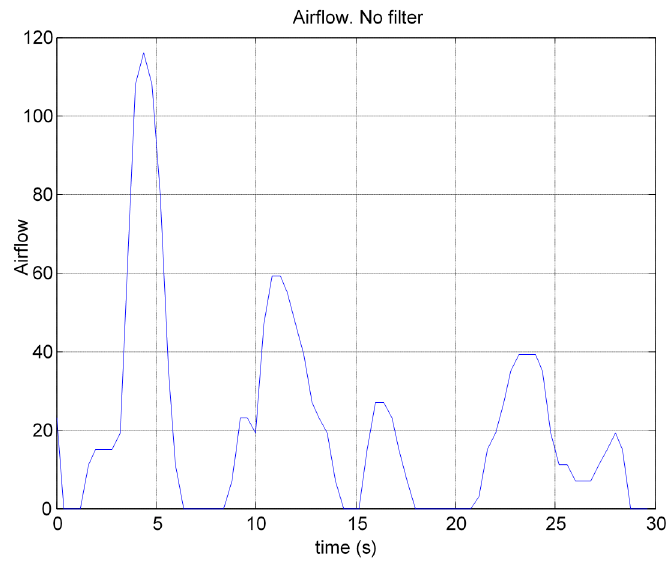
Figure 14. Airflow sensor tested; the user alternately takes a deep and a moderate breath. Filter type 2 was applied.